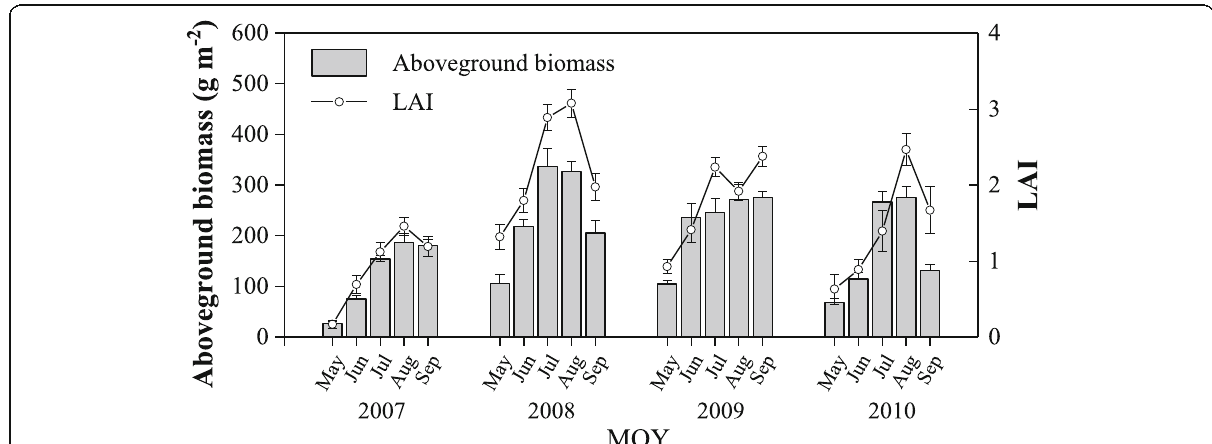
Fig. 3 Seasonal change of leaf area index (LAI) and aboveground biomass (AGB) with month in the meadow steppe during the four growing seasons of 2007 – 2010